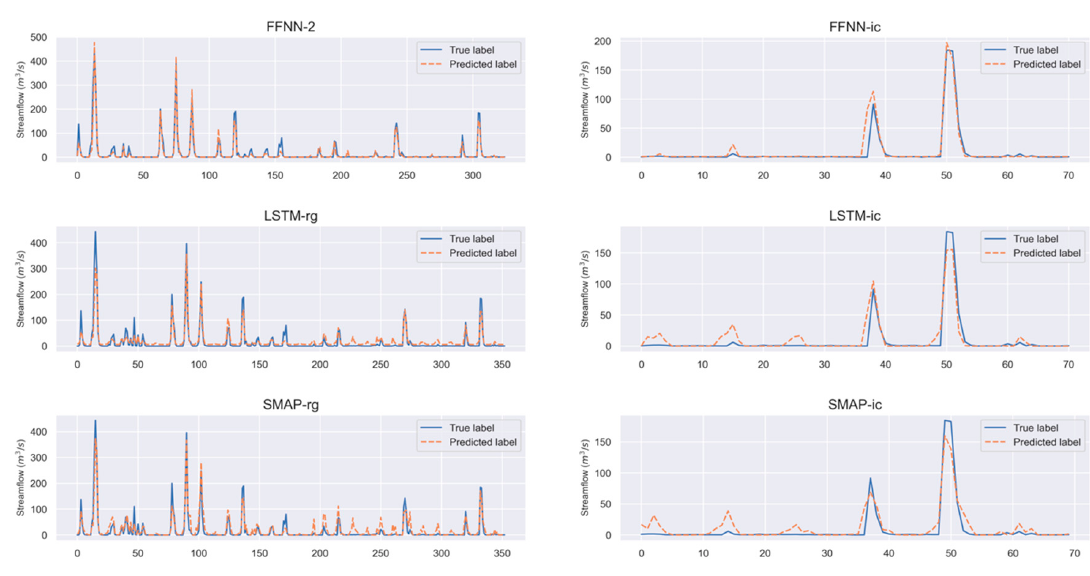
Figure 12. Time series of expected and measured values for basin 36520000.